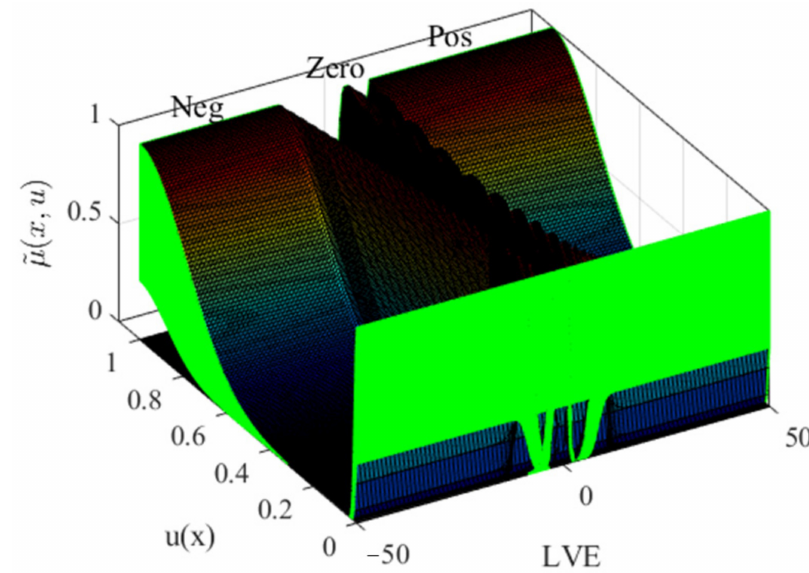
Figure 6. The architecture of the antecedent membership function (LVE).